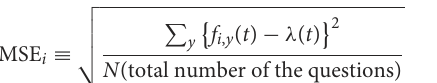
mean squared error (RMSE) was then calculated for each function defined by Equation